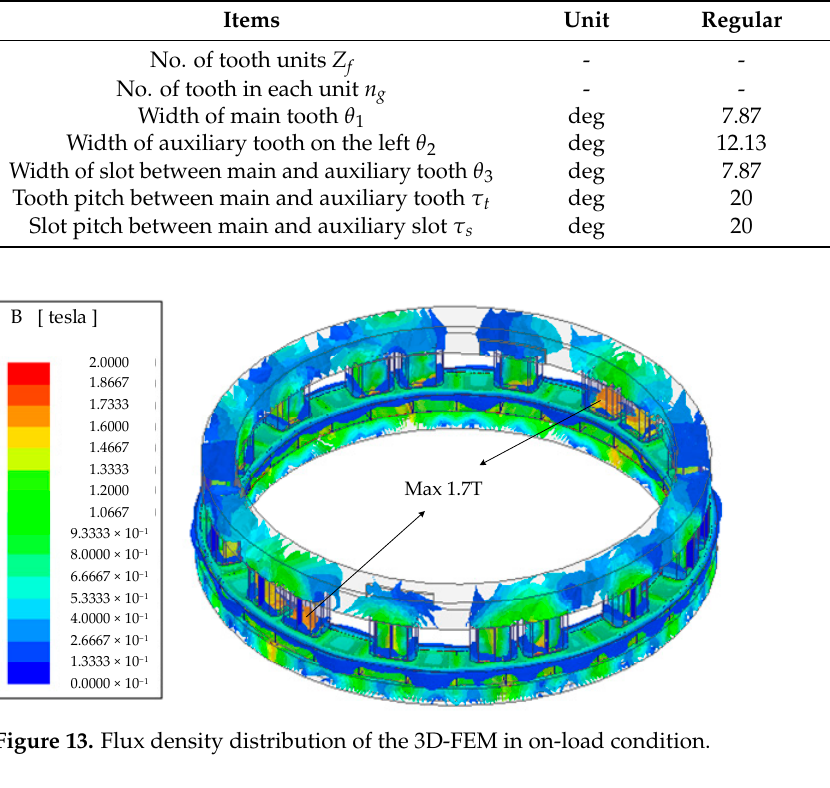
( b ) Figure 16. Cogging torque contrast by FEM. ( a ) Cogging torque. ( b ) Spectra of FFT. Table 5. Comparison of two topologies. Method